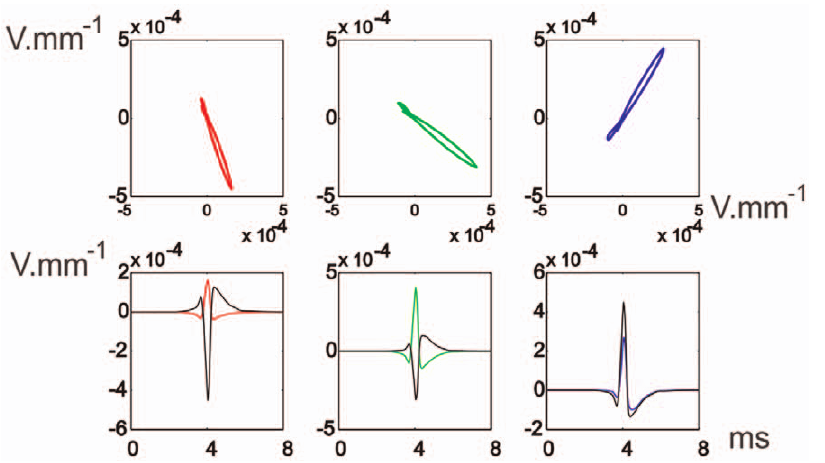
Figure 6. Far-off Electric Field. Top Field time course for 3 points at 1 fish distance from the lateral skin of the fish and with the same projections along the longitudinal axis of the red, rostral green and blue points of Figure 5. Bottom LEOD values for these three points: colored traces correspond to longitudinal values, while black traces correspond to transversal values. All calculated in a horizontal plane.